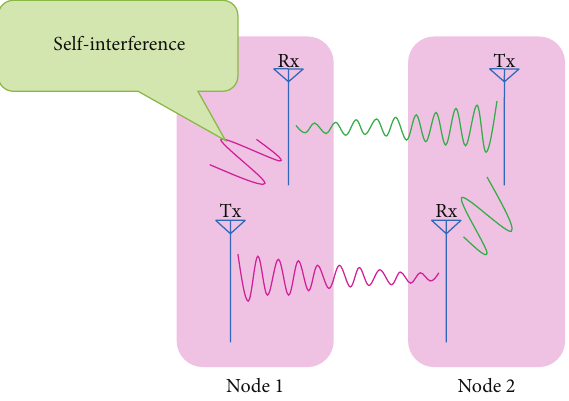
Figure 1: Self-interference in the single-channel full-duplex wireless communications using one transmitting antenna and one receiving antenna.